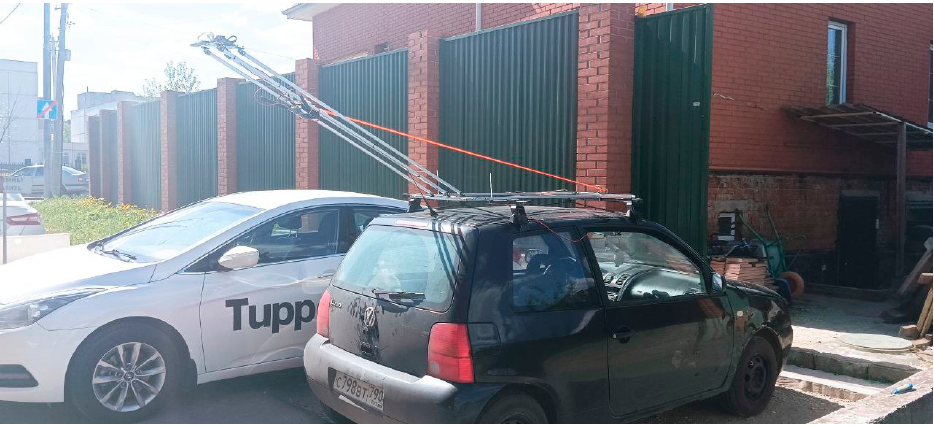
Figure 7. Data Collection Installation.